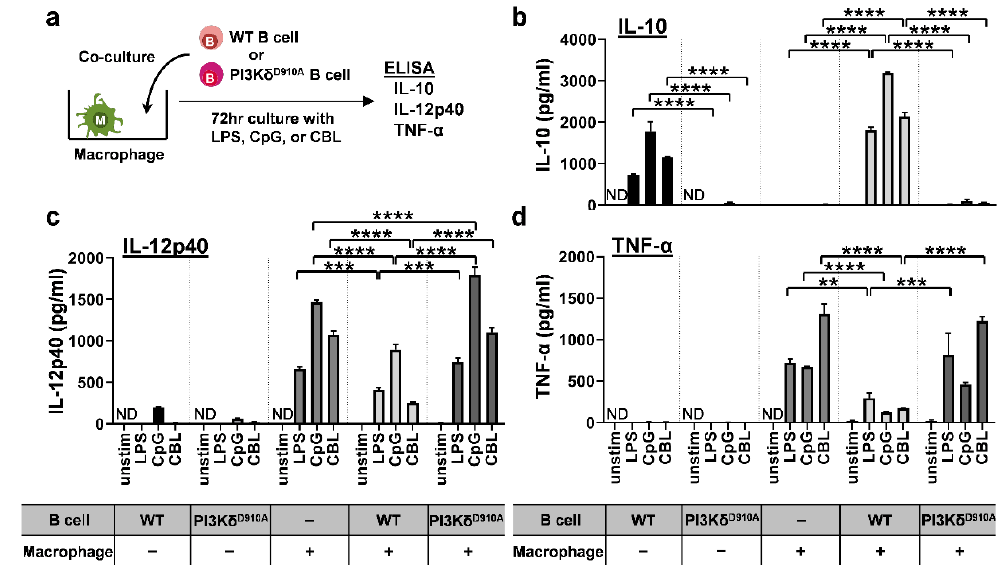
Figure 3. Bacteria-stimulated WT but not PI3K δ D910A B cells suppress IL-12p40 and TNF- α secretion by macrophages. ( a ) 1 × 10 5 J774 macrophages were cultured with 5 × 10 5 splenic B cells from C57BL/6 mice (WT) or PI3K δ D910A mice with various bacterial stimuli, LPS (200 ng/mL), CpG (500 nM), CBL (10 µg/mL) or medium alone (unstim) for 72 h in complete medium at 37 °C with 5% CO 2 . Supernatants were assessed for ( b ) IL-10, ( c ) IL-12p40, and ( d ) TNF- α by ELISA in duplicate. Mean ± SEM. N = 5–6/group. Dunn’s multiple comparisons test following 2-way ANOVA was used. ** p < 0.01, *** p < 0.001, **** p < 0.0001. ND indicates not detected.